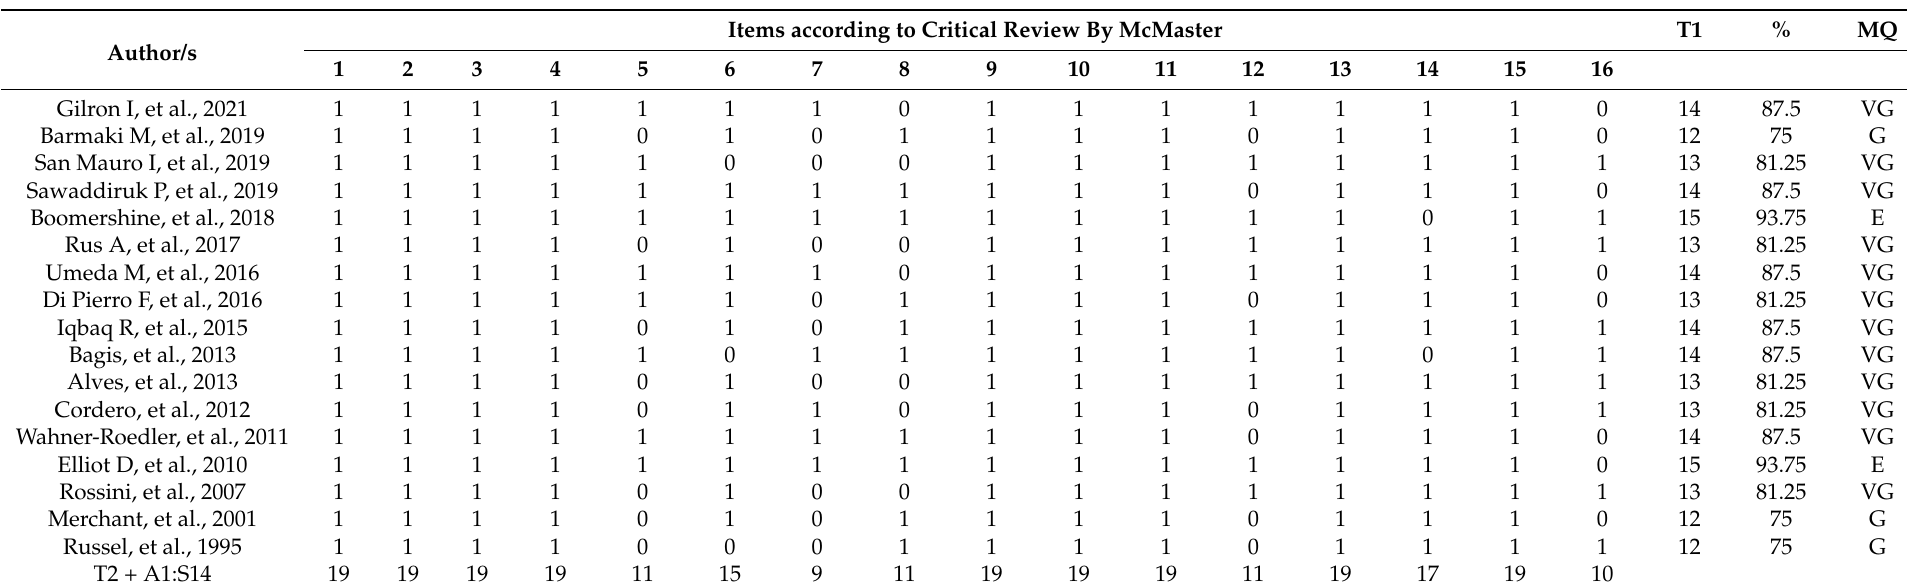
Table 1. Quality assessment of the studies included in the systematic review by McMaster critical review form for quantitative studies